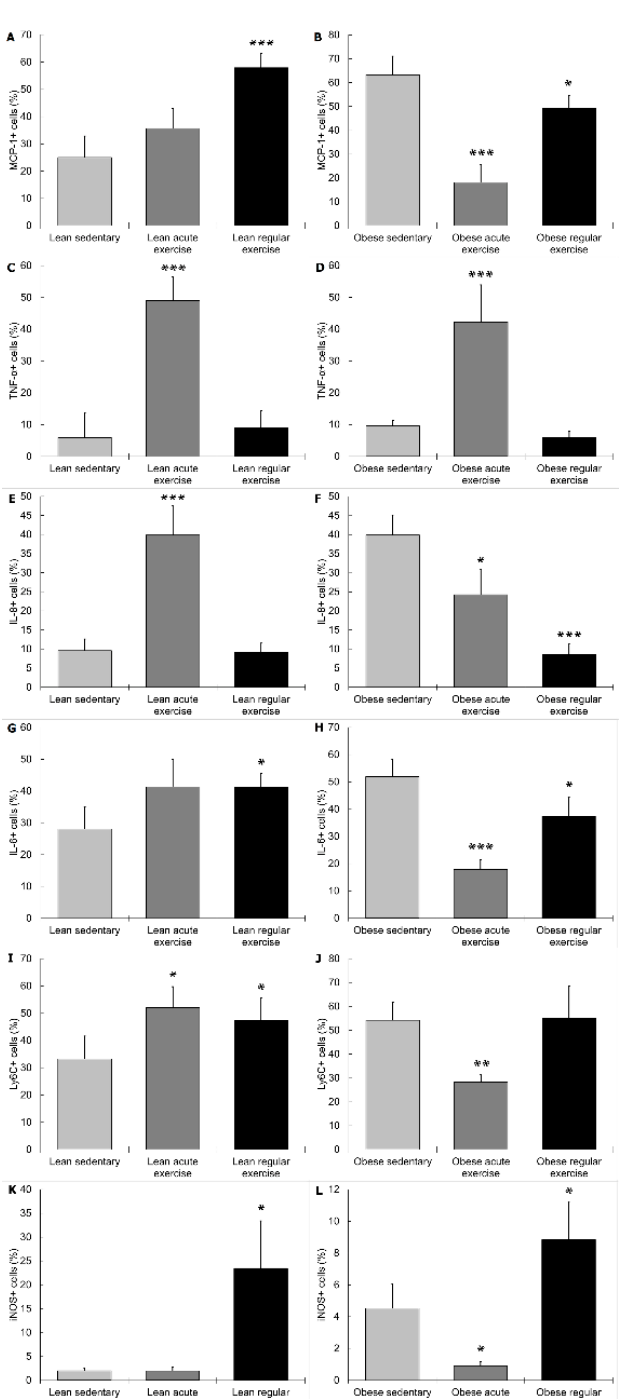
Figure 2. Effect of exercise on monocytes expressing pro-inflammatory cytokines (monocyte chemoattractant protein-1 (MCP-1), TNF- α , IL-8, IL-6) and pro-inflammatory phenotype (Ly6C, inducible nitric oxide synthase (iNOS)) in lean (sedentary n = 9; acute exercise n = 5; regular exercise n = 6) and obese mice (sedentary n = 8; acute exercise n = 5; regular exercise n = 6). ( A , B ): % MCP-1 + cells in lean and obese mice, respectively. ( C , D ): % TNF- α + cells in lean and obese mice, respectively. ( E , E ): % IL-8+ cells in lean and obese mice, respectively. ( G , H ): % IL-6+ cells in lean and obese mice, respectively. ( I , J ): % Ly6C+ cells in lean and obese mice, respectively. ( K , L ): % iNOS+ cells in lean and obese mice, respectively. Columns show the mean ± SEM of independent assays performed in duplicate in each animal. * p < 0.05, ** p < 0.01, *** p < 0.001 vs. the corresponding sedentary mice group.